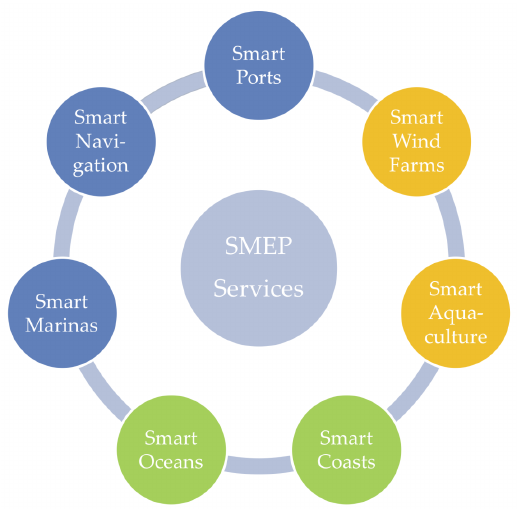
Figure 8. Smart hydrospatial data (SMEP) services across the marine information